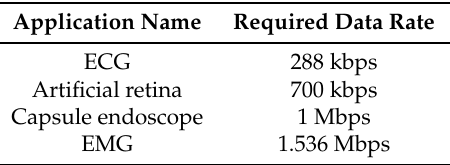
Table 2. Type of application used in the WBASN and required data rate.